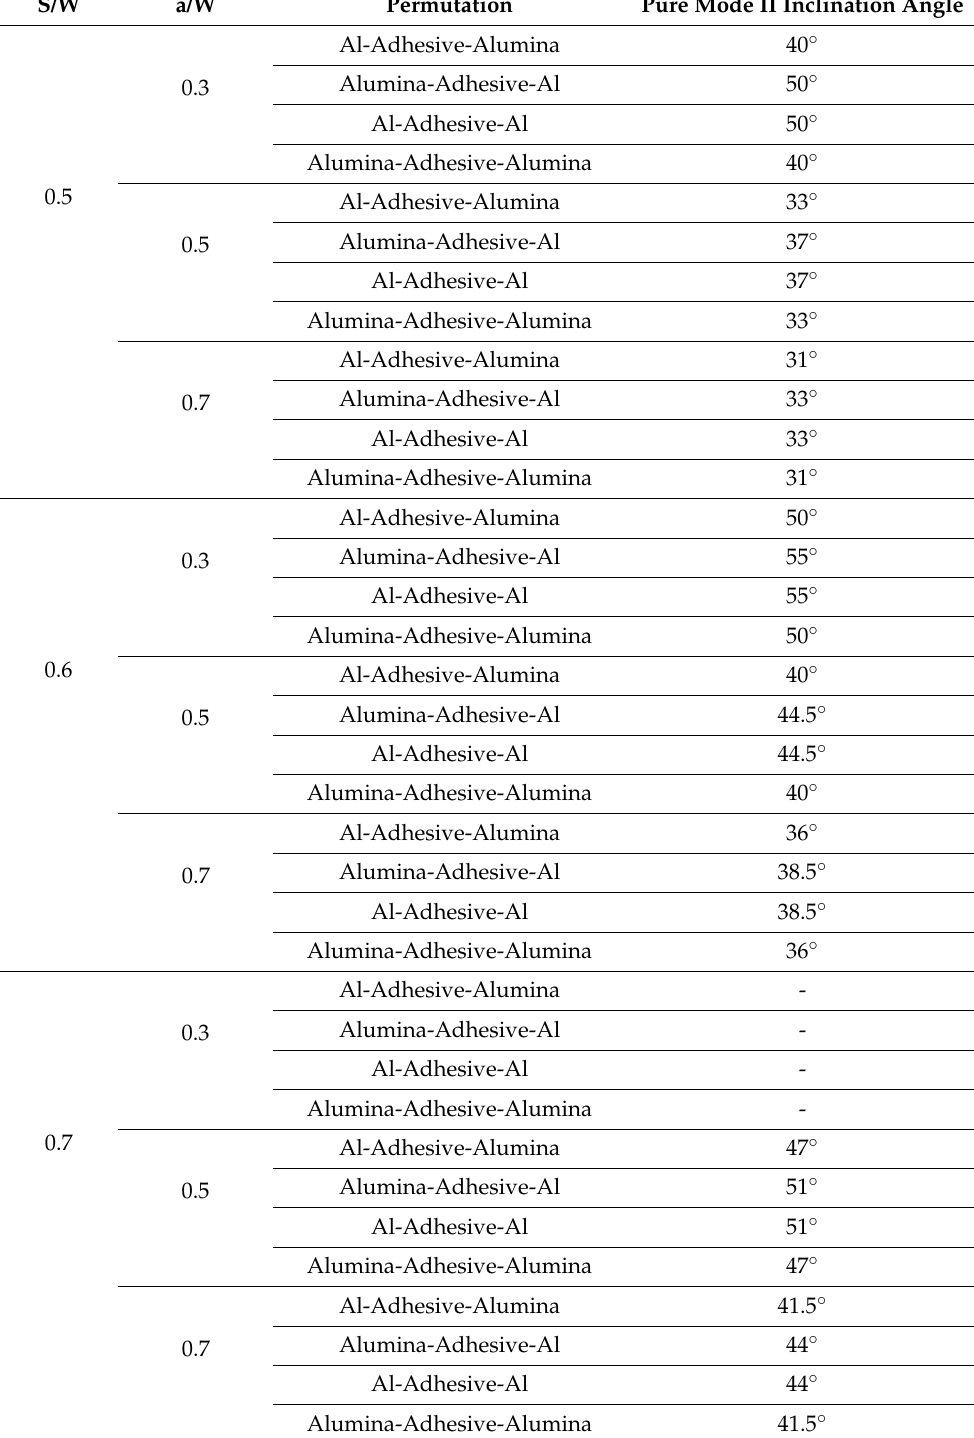
Table 2. Pure mode II crack inclination angles for the BISBB